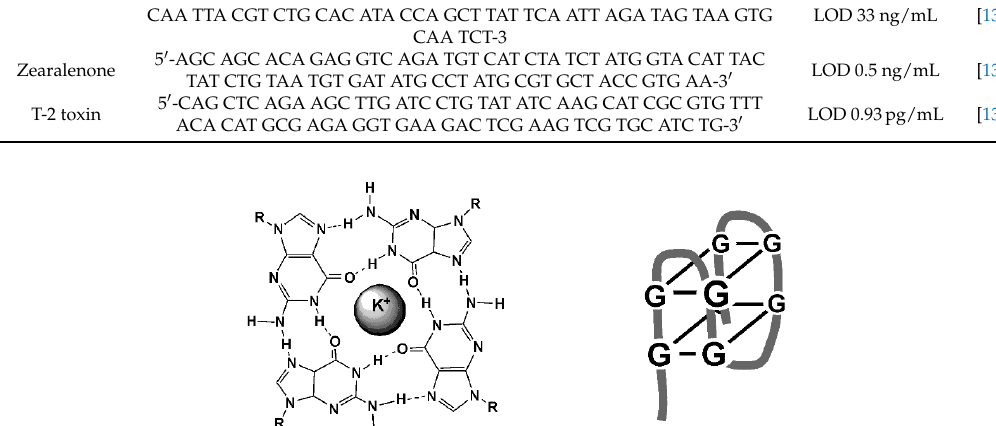
Figure 10. E-sensor based on double-labeled loop aptamer ( A ) and application of partially complementary auxiliary DNA sequence ( B ). Prior to contact with the analyte, both labels are positioned near each other so that electron exchange between the label and electrode is quite effective. The reaction with the analyte stimulated conformation change. The distance between the redox label and electrode increases with the analyte concentration and appropriate current decays. Opposite effect can be reached in so-called displacement aptasensors. In them, auxiliary DNA sequence with two terminal labels is used. The first one is utilized for immobilization of the molecule to the electrode and second one produces signal measured in direct current (DC) or DPV mode. The primary sequence of auxiliary DNA is